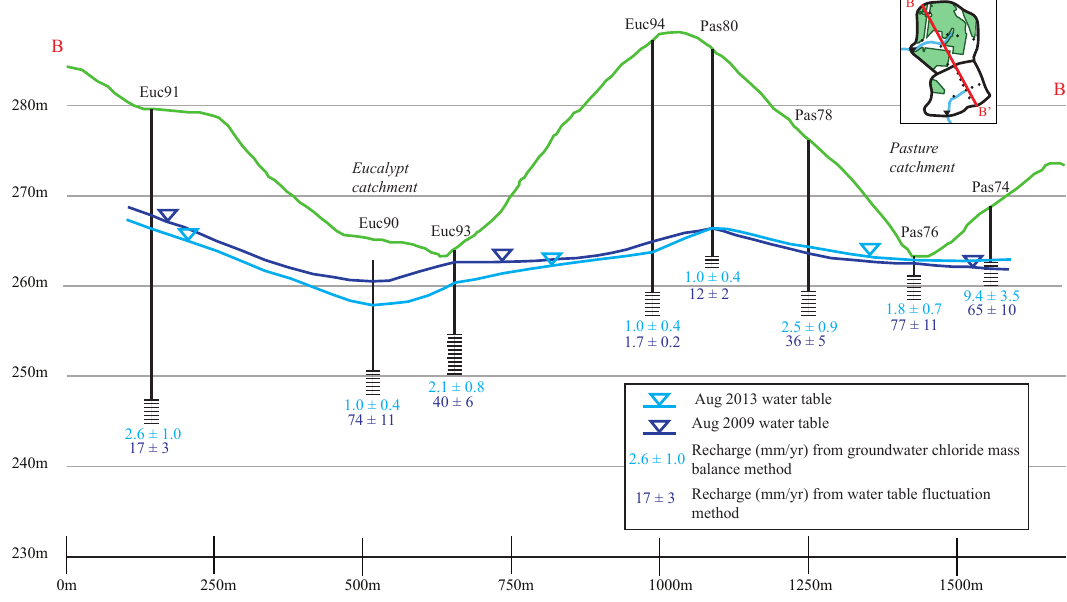
Figure 7. Cross-section from bore Euc91 across both catchments to bore Pas74 showing recharge rates based on both methods used in this study, and the water table change over the course of the study period (see Fig. 1 for bore